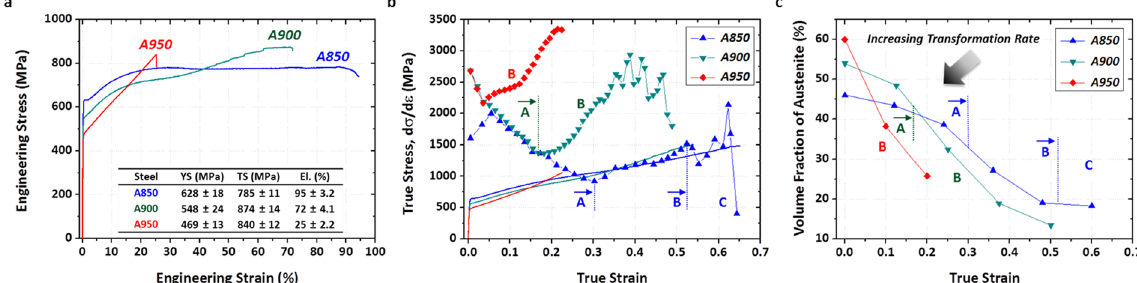
Figure 3. Tensile properties, strain hardening rate, and martensitic transformation rate of the annealed steels. ( a ) Room temperature engineering tensile stress-strain curves. ( b ) True stress-strain and strain hardening rate (d σ /d ε ) curves. In the A850 steel, the stress flow becomes steady after the rapidly increased strain hardening, while the elongation reaches 95%. The plastic instability starts to occur at the true strain of 0.25, and continues during the steady flow. In the A900 steel, the tensile strength increases to 874 MPa as the strain hardening rate increases, while the yield strength and elongation decrease. The plastic instability does not occur until the failure because the strain hardening rate is considerably higher than the true stress. ( c ) Volume fraction of austenite as a function of true strain. The volume fraction of austenite decreases with increasing true strain because of TRIP. The transformation behavior is classified into several stages, e.g ., slowly decreasing stage (Stage A), rapidly decreasing stage (Stage B), and steady stage (Stage